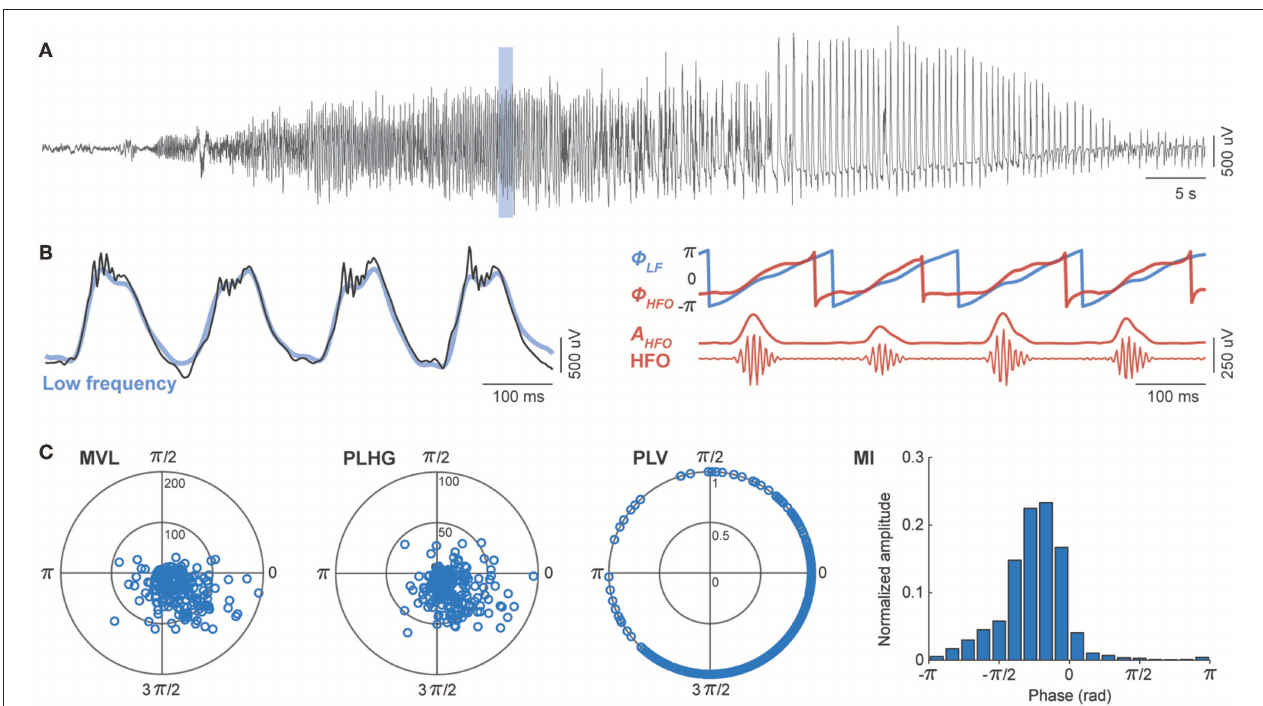
FIGURE 1 | Assessment of phase-locked HFOs using four different methods. (A) Representative channel of intracranial EEG during an epileptic seizure. (B) A temporal magnification showing high frequency oscillations (HFO) superimposed onto rhythmic low frequency (LF) signal (black). All four methods involve band-pass filtering in slow (blue) and fast (red) frequency bands. The phase-amplitude cross-frequency coupling measures are estimated from the phase of low frequency components ( Φ LF ), and either the phase ( Φ HFO ) or the amplitude ( A HFO ) of HFO envelope. (C) The mean vector length (MVL), phase-locked high gamma (PLHG), phase-locking value (PLV), and modulation index (MI) differ in the way they quantify the non-uniformity of HFO power during LF cycles (see section Assessment of Phase-Locked HFOs of the main